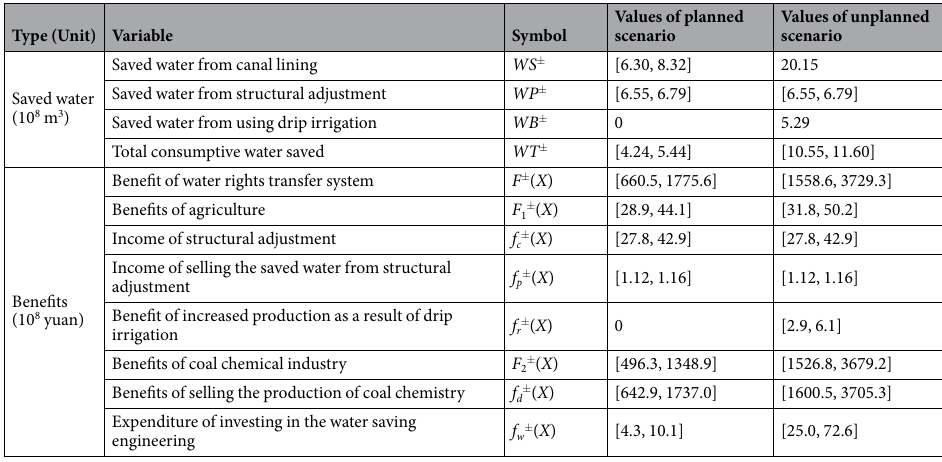
Table 3. Saved water and benefits of water rights transfer